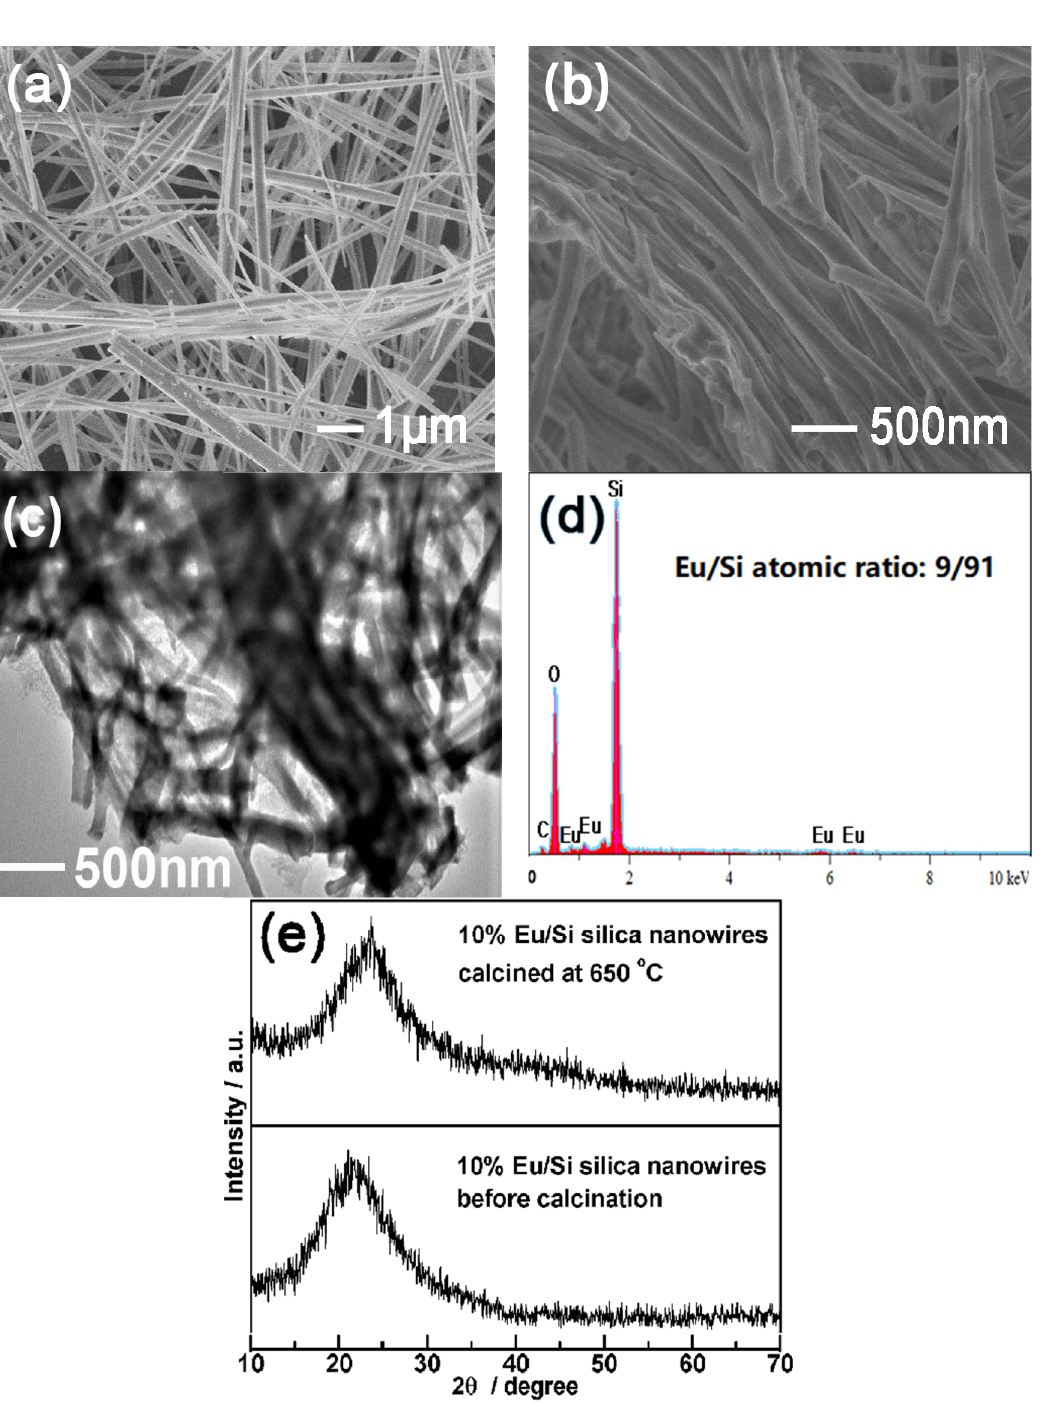
Figure 1. Trivalent europium ion-doped silica nanowires obtained (Eu/Si molar ratio is 10%) at 25 °C: ( a ) SEM image without calcination; ( b ) SEM image of calcinated sample; ( c ) TEM image of calcinated sample; ( d ) EDX patterns of calcinated sample; ( e ) XRD patterns.